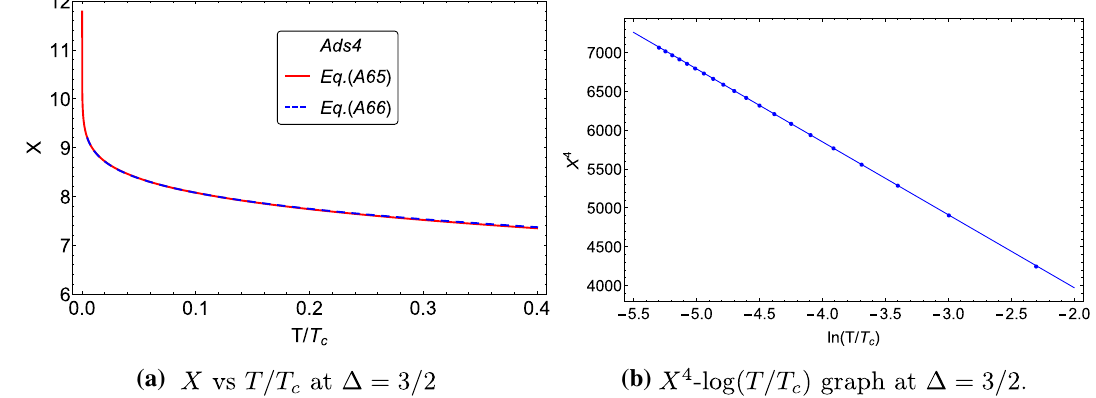
Fig. 15 a X vs T / T c : red colored curves for X is a plot of Eq. (A.44). And blue dashed curves is a plot of Eq. (A.45). These two curves are almost identical for low temperature. b X 4 -log ( T / T c ) graph at (cid:2) = 3 / 2: The slope of blue dotted line for X 4 is − 939